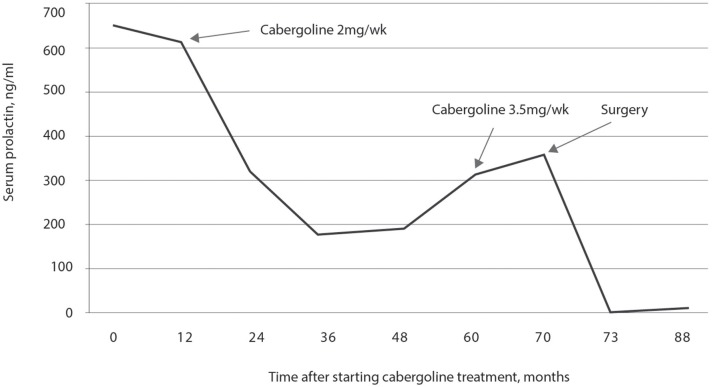
Prolactin concentration in response to treatment with 2.0 mg per week of cabergoline. A progressive decrease in prolactin concentrations was observed up to 36 months of treatment, remaining stable for 12 months, and then gradually increasing to reach the maximum value at 70 months of treatment when transsphenoidal surgery was performed with resolution of hyperprolactinemia.